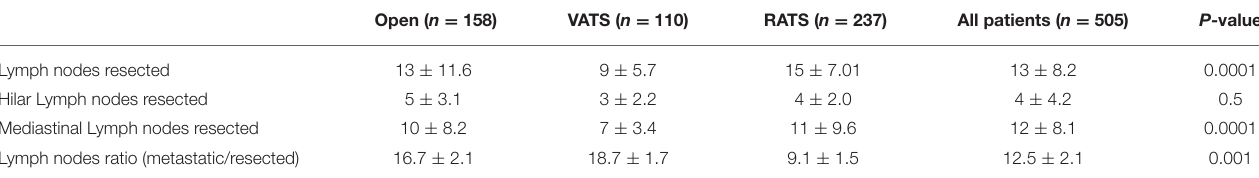
TABLE 4 | Lymph nodes features in the Robotic, VATS, and Thoracotomy